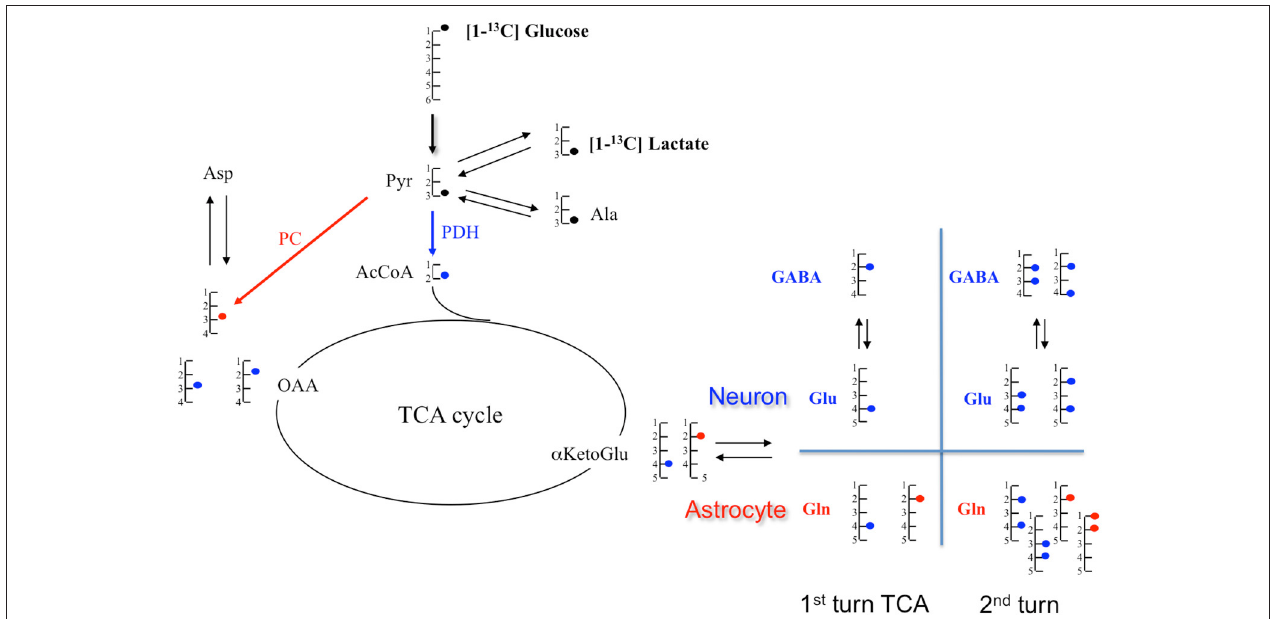
FIGURE 4 | Schematic representation of metabolite labeling from [1- 13 C]glucose during the first tricarboxylic acid (TCA) cycle turn. In astrocytes, [1- 13 C]glucose follows either the pyruvate dehydrogenase (PDH; ) or the pyruvate carboxylase (PC; ), but only the PDH pathway occurs in neurons. At the end of the glycolysis, [1- 13 C]glucose provides [3- 13 C]pyruvate which can take two paths: either pyruvate dehydrogenase (PDH; ) or pyruvate carboxylase (PC; ). In the PDH pathway, [3- 13 C]pyruvate gives [2- 13 C]AcCoA which enters in the TCA cycle and leads to [4- 13 C]citrate, then to [4- 13 C] α KG. This intermediate α KG forms [4- 13 C]glutamate, which is metabolized in [4- 13 C]glutamine. Through TCA cycle, by the symmetry of some intermediates, [4- 13 C] α KG gives two isotopomers of OAA: [2- 13 C]OAA (50%) and [3- 13 C]OAA (50%). Then, it provides Asparate labeled in [2- 13 C] (50%) and [3- 13 C](50%). In the PC pathway (only in astrocyte compartment), [3- 13 C]pyruvate is converted in [3- 13 C]OAA which enters TCA cycle to form [2- 13 C] α KetoGlu which leads to [2- 13 C]glutamate and then to [2- 13 C]glutamine. α -KG, α -ketoglutarate; Ala, alanine; AcCoA, acetyl-CoA; Glu, glutamate; Gln, glutamine; GABA, γ -aminobutyric acid; Lac, lactate; OAA, oxaloacetate.